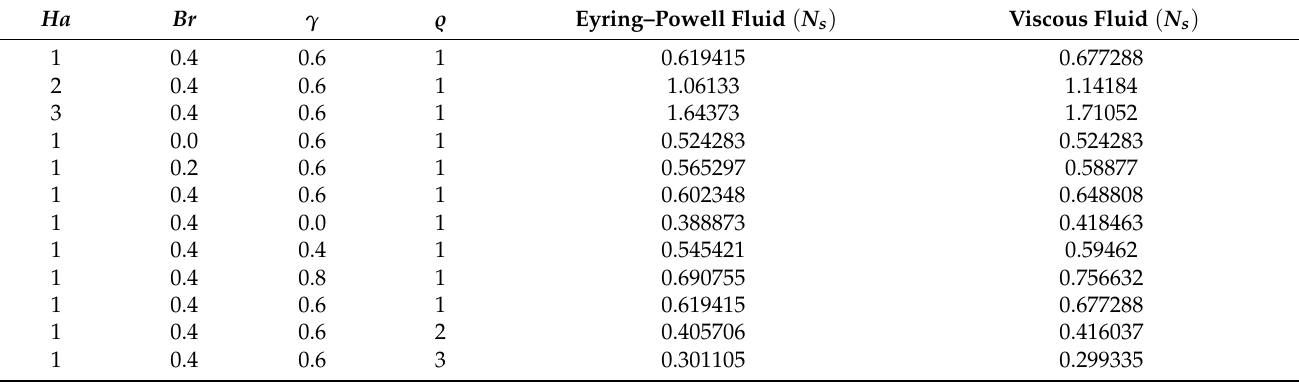
Table 1. Comparison for entropy generation rate N s between Eyring–Powell fluid and viscous fluid when and other fixed parameters are b 1 = 0.3, b 2 = 0.5, x = 0.5, l = 1, U HS = −